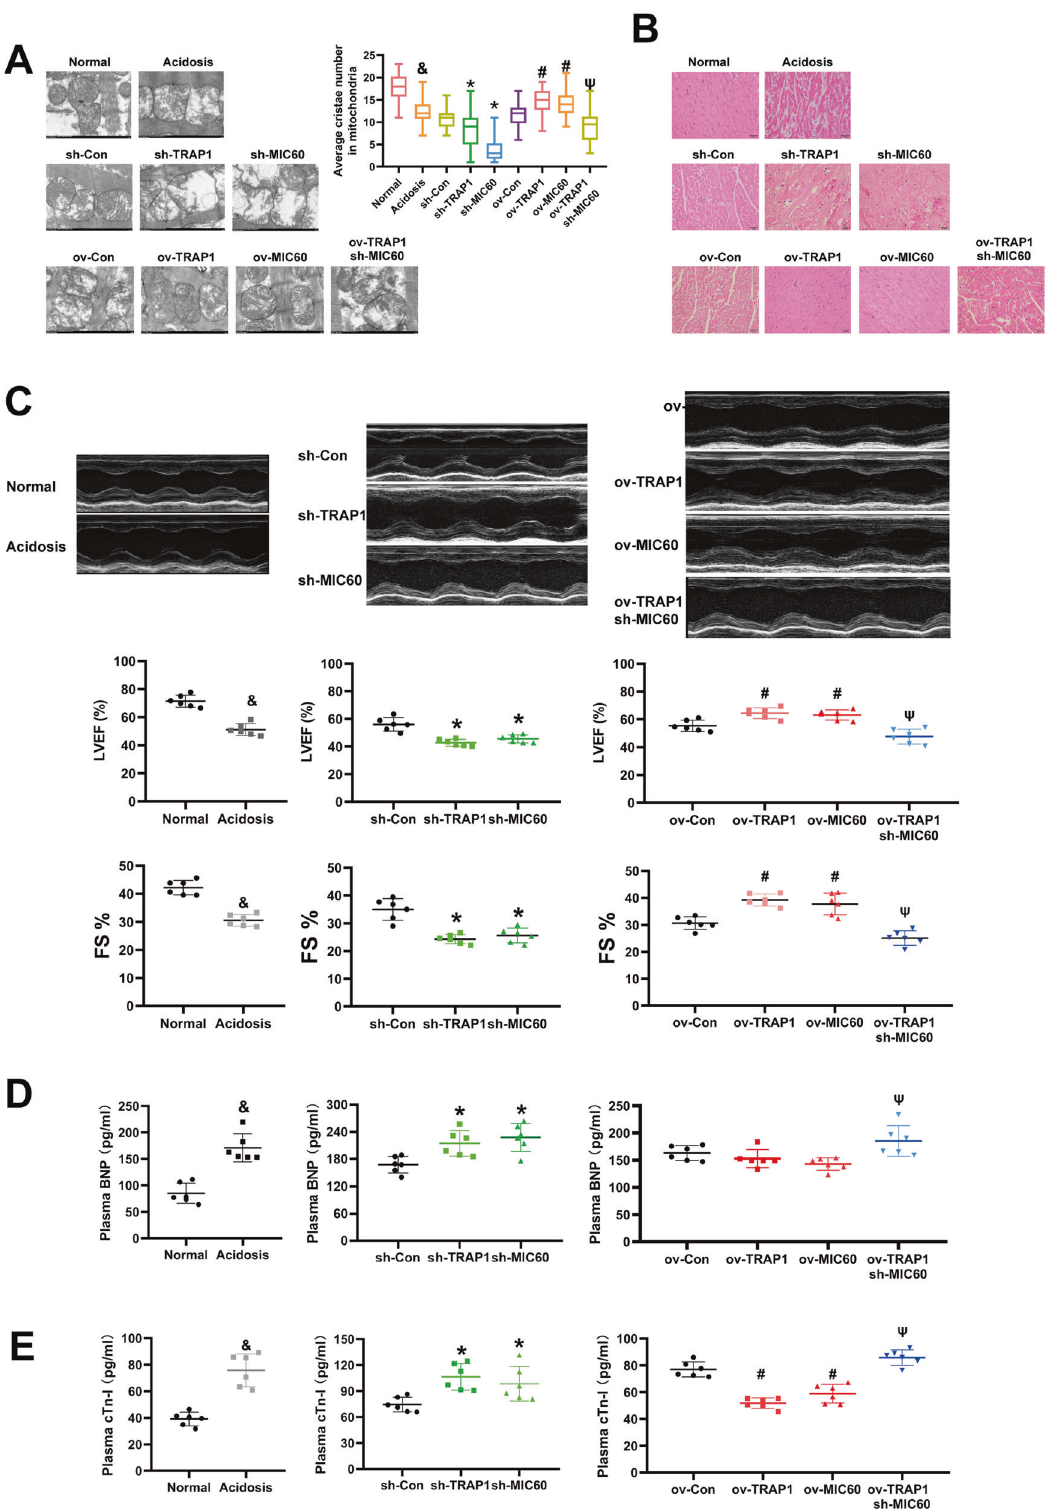
Fig. 6 TRAP1 protected cardiac function and mitochondrial cristae of rats ’ heart by increasing MIC60 protein levels in extracellular acidosis. A Transmission electron microscopy was used to detect the ultrastructure of mitochondria of rats ’ heart tissue. Twenty- fi ve images were obtained from fi ve rats for each group. The average cristae number in one mitochondrion ( n = 30 mitochondria for each group randomly selected from 25 pictures) of each group was quanti fi ed. B HE staining was used to detect tissue injury of rats ’ heart tissue. C Echocardiography was used to detect cardiac functions of rats including LVEF. D – E Elisa assay was used to detect serum BNP ( D ) and cTnI ( E ). Data were the means ± SD from six rats. Group comparisons were performed by one-way analysis of variance followed by Tukey ’ s post hoc test. & P < 0.05 vs. Normal group. * P < 0.05 vs. sh-Con group. # P < 0.05 vs. ov-Con group. ψ P < 0.05 vs. ov-TRAP1 group or ov-MIC60